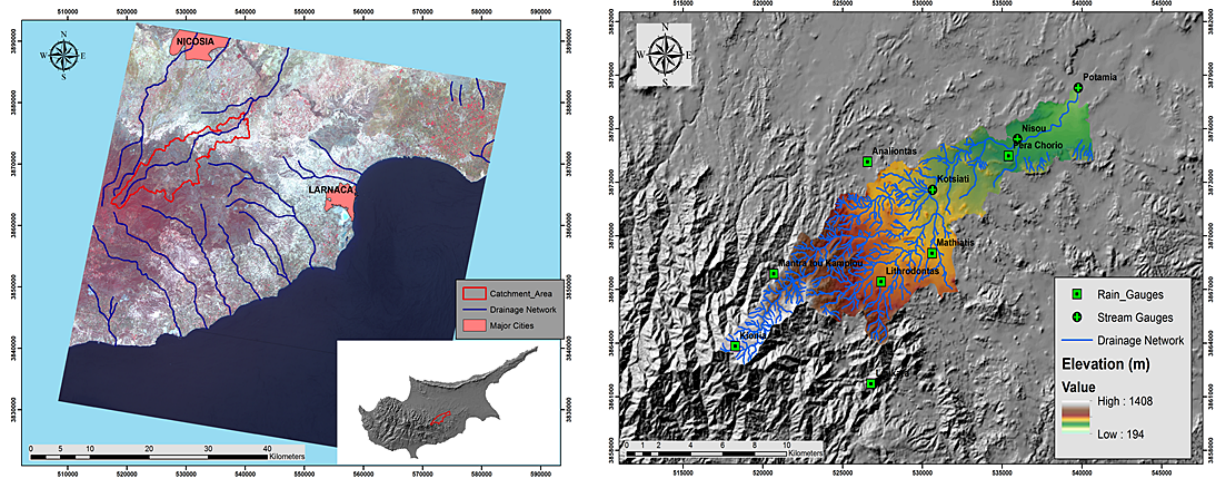
Fig. 1. (a) Study Area as indicated in the RGB-321 of ASTER image, (a) location of rain and stream gauges stations, (b) a digital elevation model (DEM) of 10m pixel created with the use of orthorectified stereo pairs of aerial photos (scale 1 : 5000) covering the study area. Table 1. Characteristics of the study area’s rain and flow gauge stations. Stations Longitude